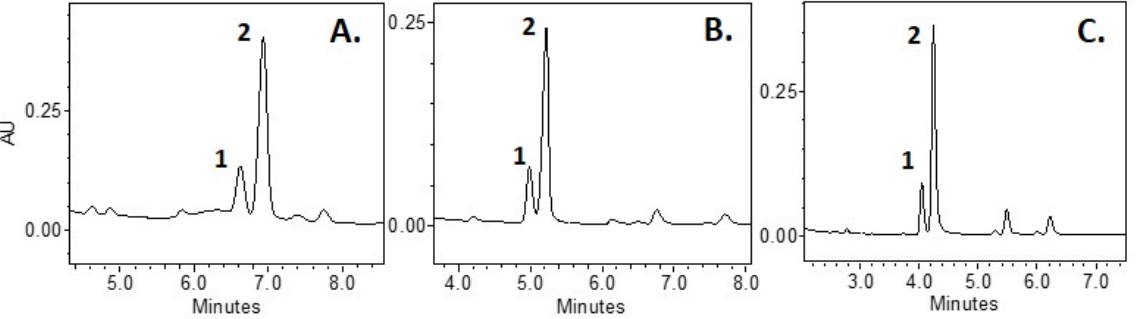
Figure 1. Chromatograms of 1-oleaonolic acid and 2-ursolic acid using different eluents, flow rate 0.2 mL/min. ( A ) Isocratic elution with 100% methanol ( A ) and 100% acetonitrile ( B ): 0 min, 15% A; 8 min, 15% A, 20 °C; ( B ) Isocratic elution with H 2 O ( A ) and 100% acetonitrile ( B ): 0 min, 12% A; 8 min, 12% A, 20 °C; ( C ) Gradient elution with 0.1% formic acid ( v / v ) ( A ) and 100% methanol ( B ): 0 min, 8% A; 8 min, 3% A, 25